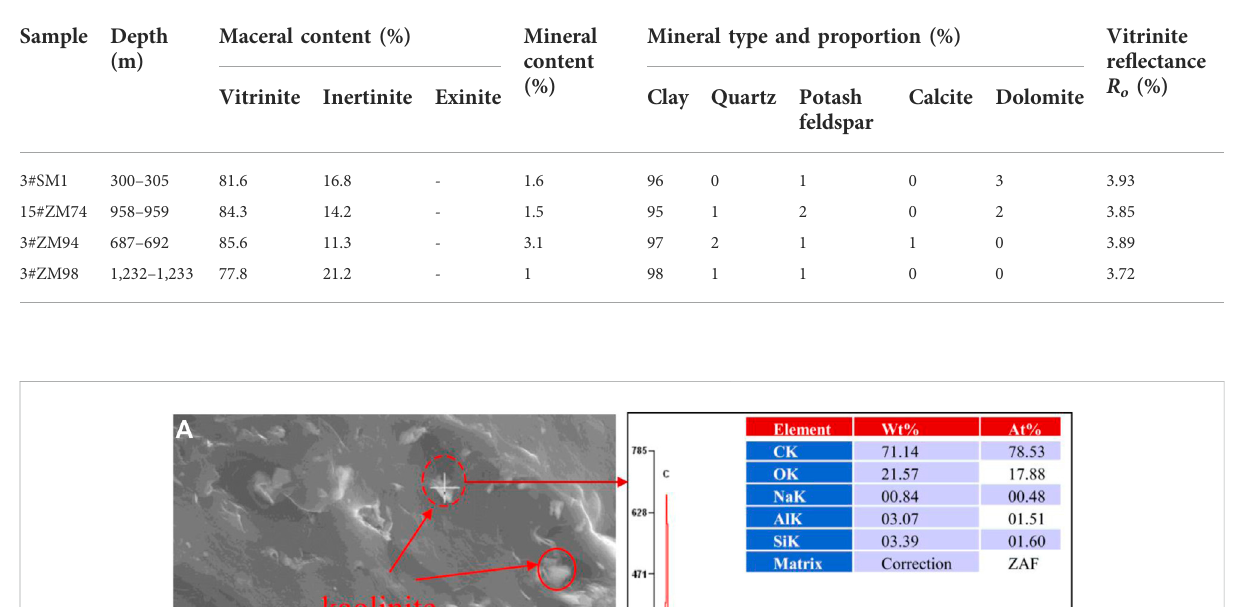
TABLE 1 Component analysis of coal samples.